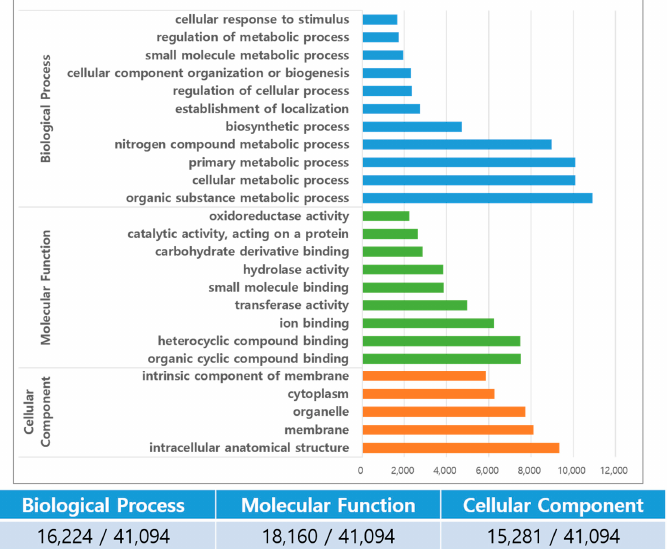
Figure 3. GO analysis of the C. robustum transcriptomes. The numbers at the bottom represent the number of transcripts in the three GO categories from whole set of transcriptomes. 3.4. Di ff erences of the Genes Expressed among Leaves, Stem, and Fruit in C. robustum Of the 41,094 transcripts obtained in C. robustum , the numbers of transcripts ex-